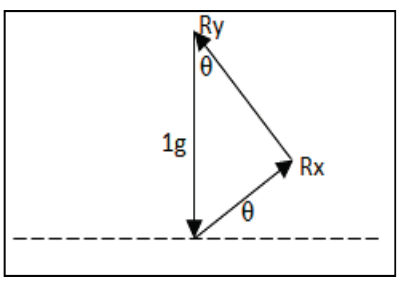
Figure 4. The combination of x and y vectors in two axis